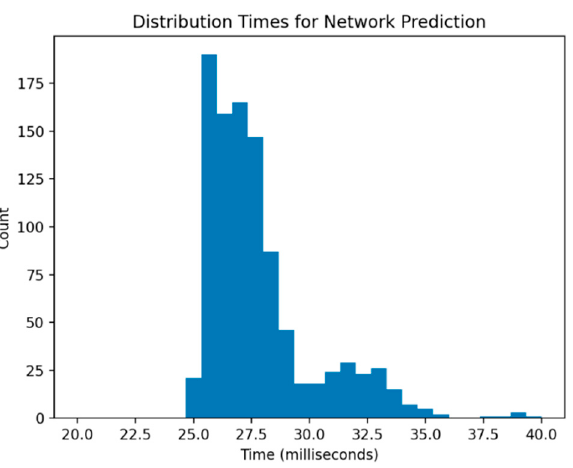
Figure 7. Computation times across 1000 random input samples using our fully trained neural network model.